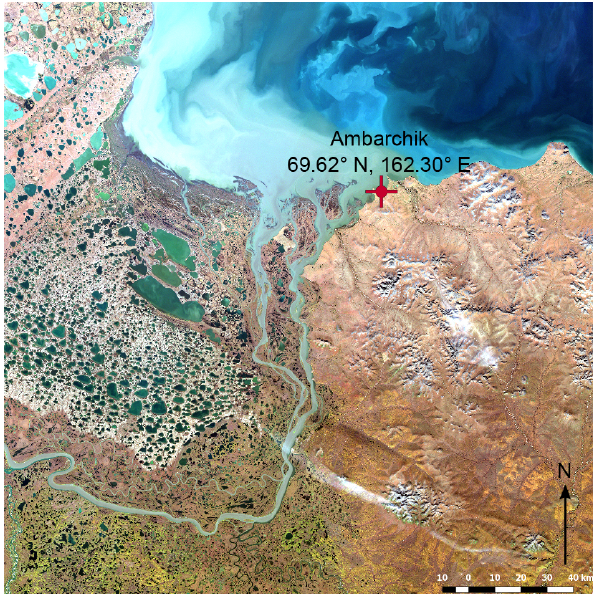
Figure 2. Ambarchik station location. Background based on Coper- nicus Sentinel data from